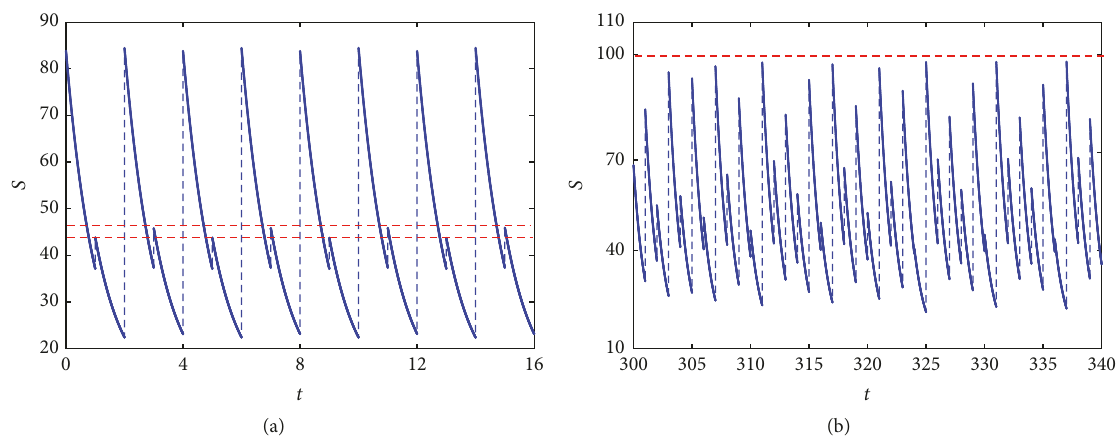
Figure 4: (a) The period- 4𝑇 solution of (39) with 𝑏 = 7.25 ; (b) the solution of (39) with 𝑏 = 7.85 .